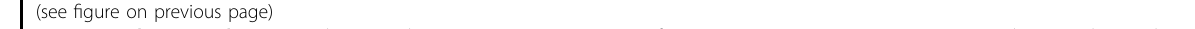
between genotype and session ( E = 0.79, CrI = [0.18, 1.48]). However, genotype and session effects were not signi fi cant under the LR condition (genotype: − 0.45, CrI For the near-LR stimulus (Fig. 4H), no signi fi cant effects were found (genotype: E = − 0.26, CrI = [ − 1.2, 0.69];